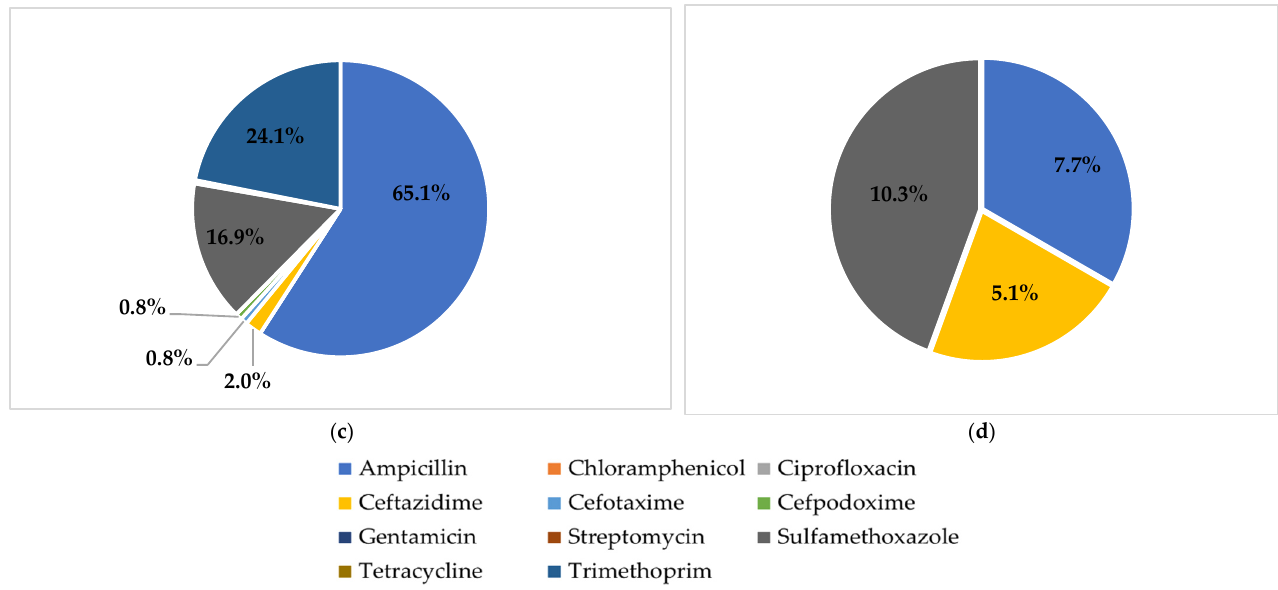
Figure 1. Proportion of phenotypic AMR for different species of bacteria. ( a ): E. coli ; ( b ): S. enterica subsp. enterica ; ( c ): V. parahaemolyticus ; ( d ): V. cholerae .